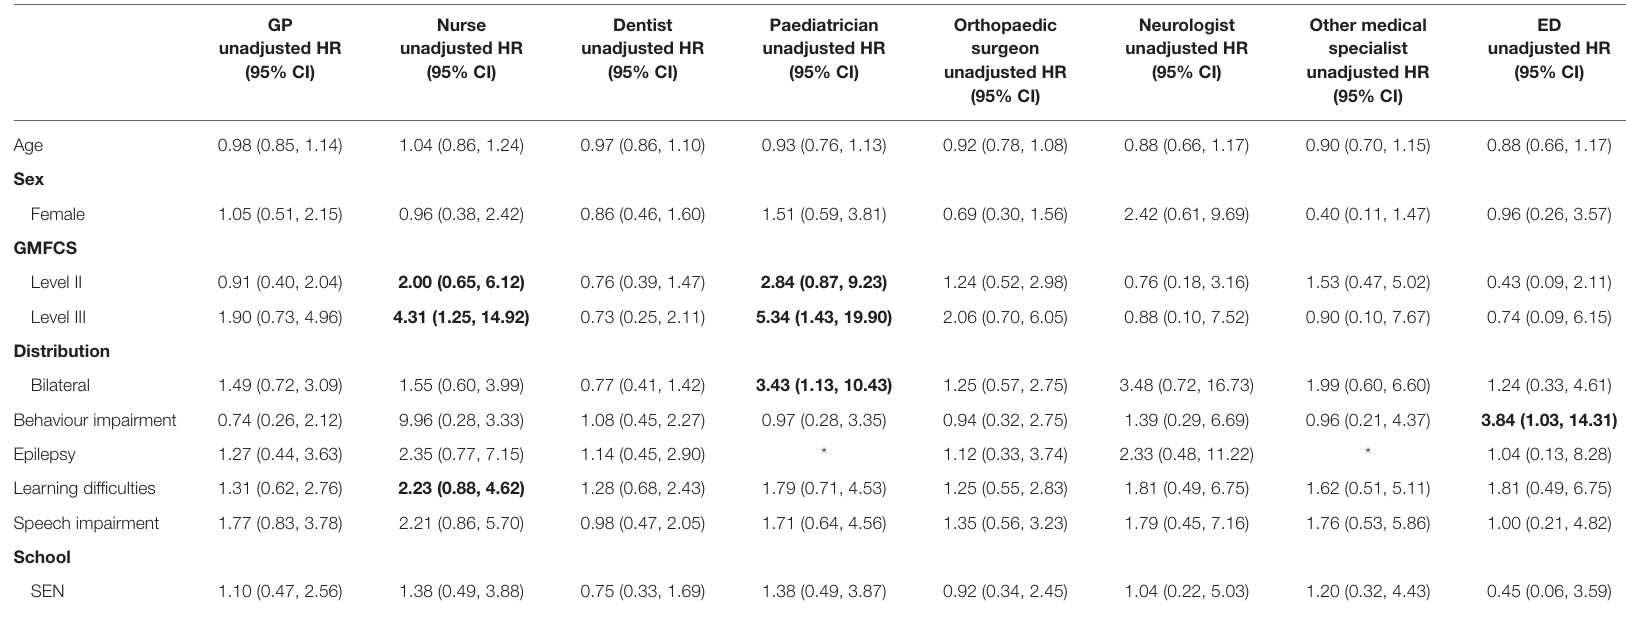
Bold text indicates p < 0.010. * Unable to